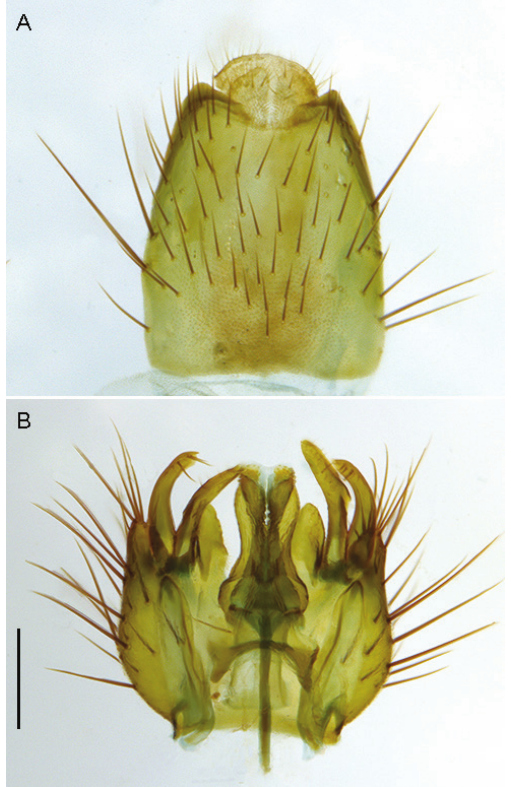
Figure 23. Zelothrix warrumbungles sp. n.: Male genitalia: A Epandrium, dorsal view B Gonocoxites and aedeagus, dorsal view (epandrium removed). Scale line: 0.2 mm. brown to black suffusion; tibiae and tarsomeres 1 and 2 dark yellow, brown apically; remaining tarsomeres dark brown; wing distinctly infuscate with extensive mottled pattern; venation dark. Abdomen . Slender, elongate, bright yellow with small dark brown area anteromedially on tergites in male, tergites more extensively dark brown in female and overlain with sparse grey pubescence; sparse thin elongate setae on all segments, mostly pale, but darker dorsomedially and on terminalia. Male Termina- lia . (Fig. 23) Epandrium longer than wide, slightly tapered posteriorly, sclerotised posterolaterally, setae sparse, more elongate laterally; cercus relatively small; gono- coxites rounded with short round outer gonocoxal process; hypandrium small and fused to gonocoxites anteriorly; gonocoxal apodemes small and rounded; setae on gonocoxites sparse, elongate and erect, with sparse velutum ventrally on gonocox- ite; inner gonocoxal process and gonostylus narrow and curved medially; ventral lobe elongate and rounded apically; dorsal apodeme of parameral sheath ‘T’-shaped; ventral lobe broad, not forked and projecting beyond dorsal apodeme; distiphallus broad, irregularly shaped dorsally, small spines apically; lateral ejaculatory